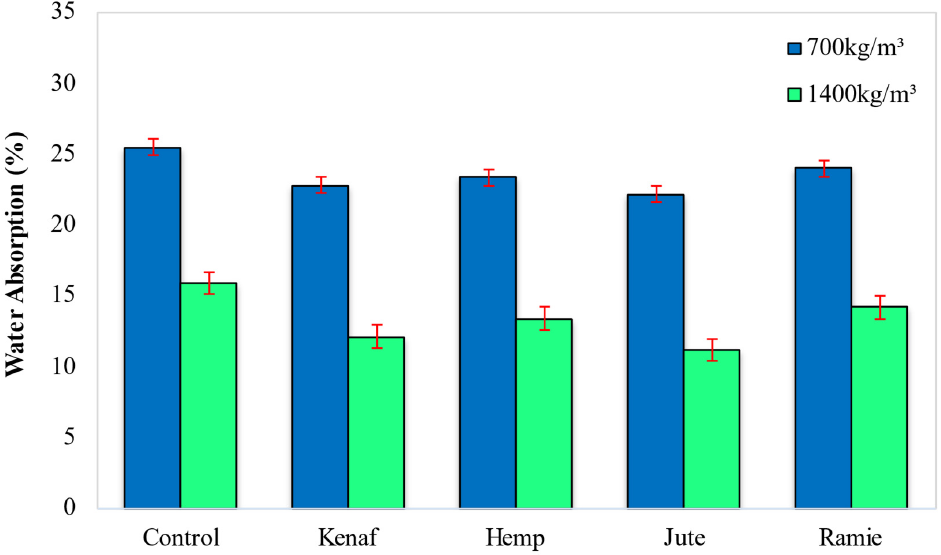
Figure 10. Effect of different types of fiber on LFC water absorption.